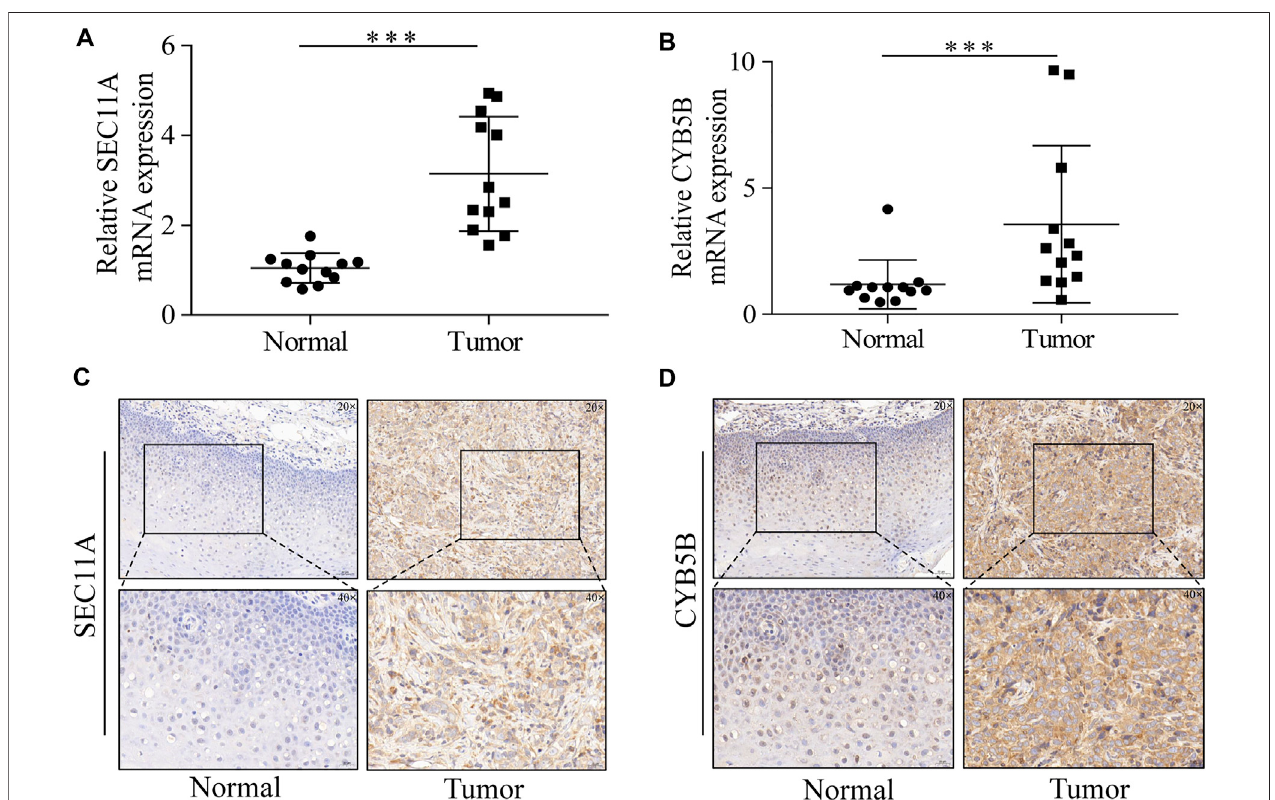
FIGURE 9 | SEC11A and CYB5B expression is upregulated in HNSCC. (A) qRT-PCR analysis of SEC11A mRNA levels in tumor and adjacent normal tissues. (B) qRT-PCRanalysisofCYB5BmRNAlevelsintumorandadjacentnormaltissues. (C) IHCanalysisofSEC11Aproteinlevelsintumorandadjacentnormaltissues. (D) IHC analysisofCYB5Bproteinlevelsintumorandadjacentnormaltissues.***, p < 0.001.Abbreviations:CYB5B,cytochromeB5typeB;HNSCC,headandnecksquamous cell carcinoma; IHC, immunohistochemistry; mRNA, messenger ribonucleic acid; qRT-PCR, quantitative real-time polymerase chain reaction; SEC11A, signal peptidase complex catalytic